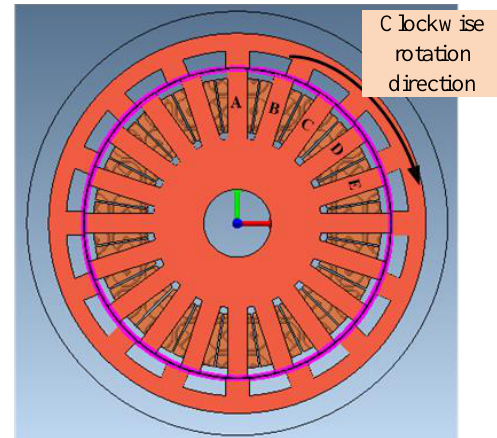
Figure 2. SRM circuit topology. ( a ) One phase (the other four phases are similar); ( b ) Drive circuit.